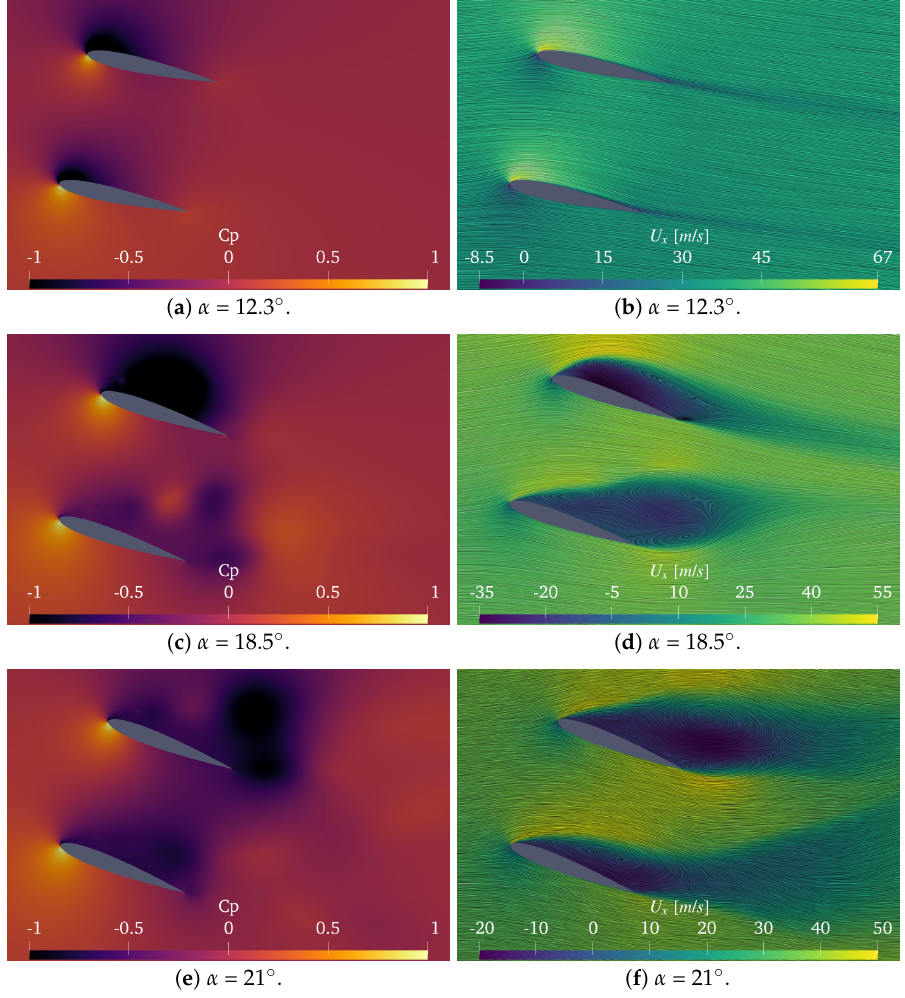
Figure 12. Root section: C p ( left ) and U x ( right ) contours at different angles of attack (note that colours match different values for each α )